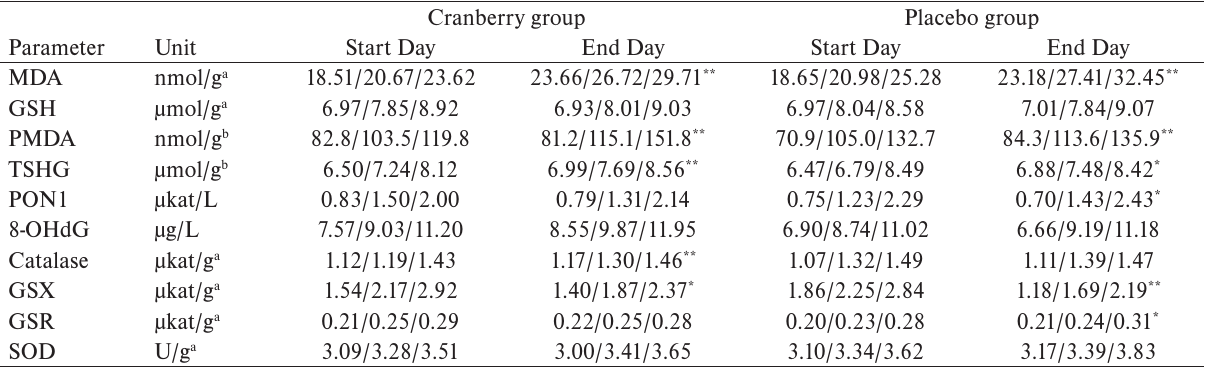
Table 5. Markers of oxidative stress in blood. Cranberry group Placebo